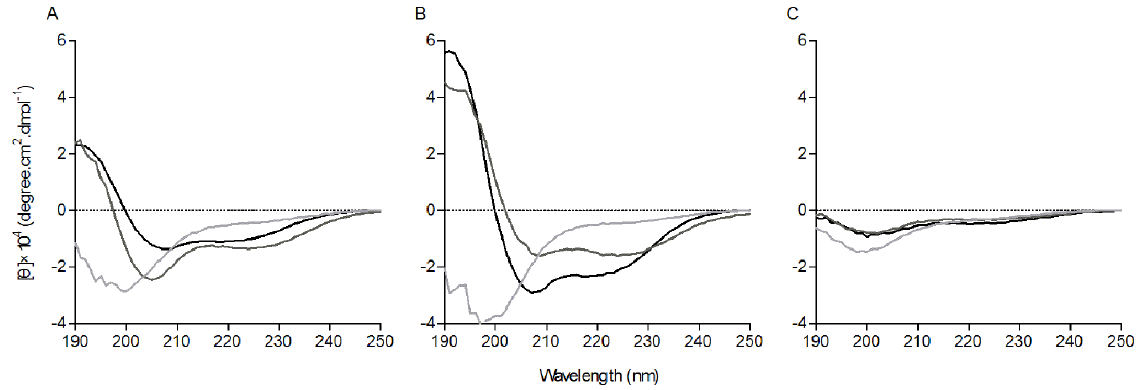
Figure 8. CD spectra of the peptides in aqueous solution (light grey), 30 mM SDS micelles (dark grey), and 50% TFE (black). The circular dichroism spectra were measured at 25 u C using a J-820 spectropolarimeter. The samples were loaded in a rectangular quartz cell (0.1 cm path length), and the spectra were recorded at a scanning speed of 10 nm/min in the wavelength range of 190 to 250 nm. (A) PMAP-36; (B) GI24; (C) PG12.